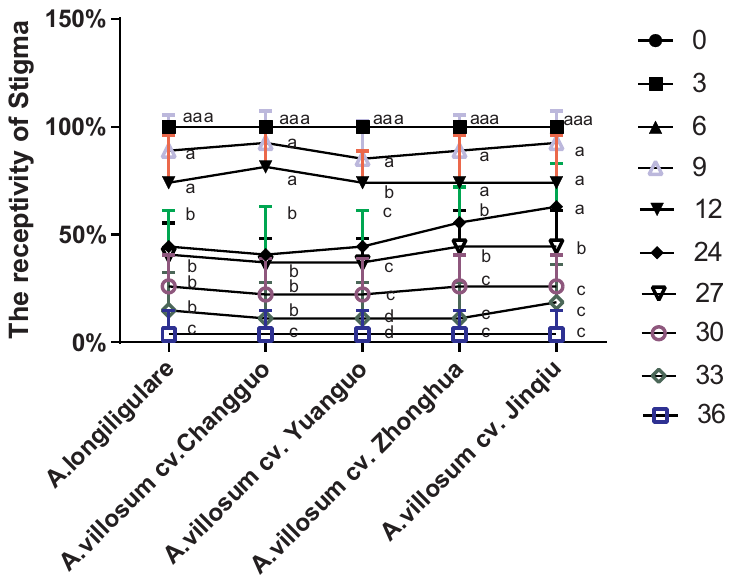
Fig 4. Stigma receptivity of the 5 herbaceous Amomum varieties. n = 3 per group. Data are presented as mean ± SD. Means within a cultivar followed by the same letters do not differ at P < 0.05 ( SNK test ).